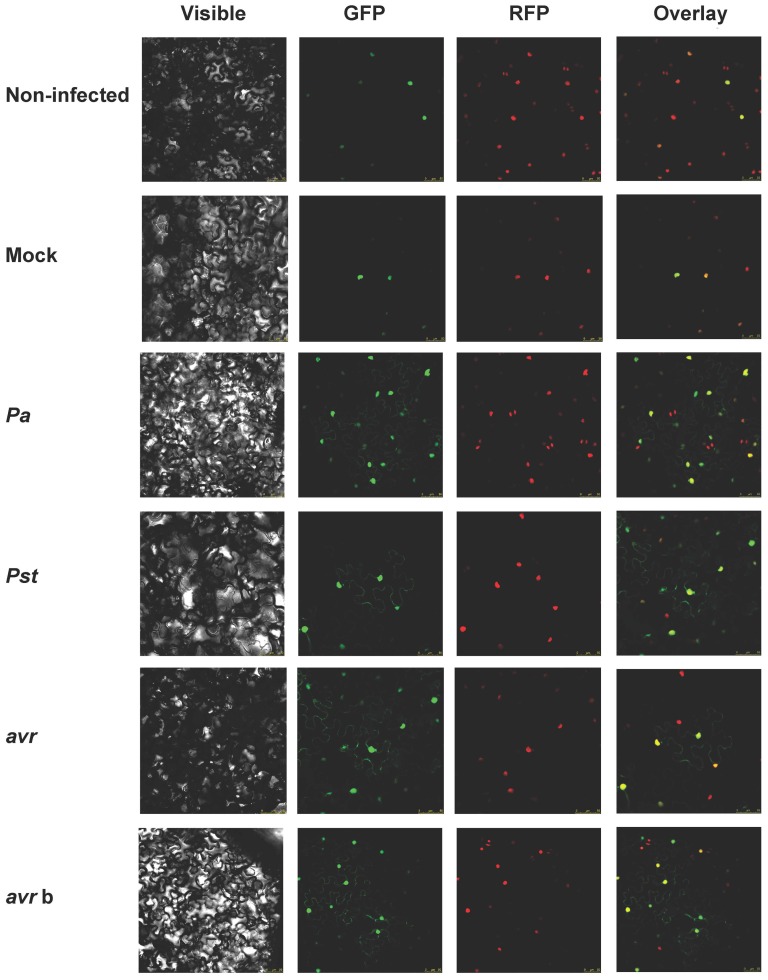

GFP-ATERF-1 localisation after inoculation with Pseudomonas strains.Confocal microscopy of N. benthamiana leaves over-expressing GFP-ATERF-1 together with a RFP-tagged nuclear marker (RFP-H2B transgenic line). Non-infected control and plants inoculated with an sterile solution of MgS04 (Mock) or with a bacterial suspension of Pa, Pst, Pst(avrRpt2) (avr) or boiled avr (avr b) strains. Photographs were taken 3–5 h. after the inoculation.